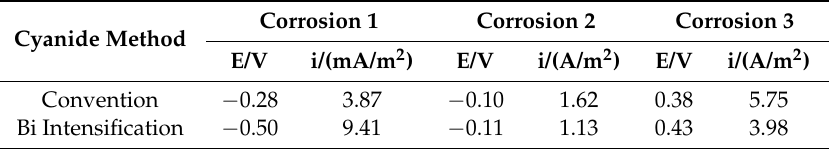
Table 1. Tafel results of gold electrode in cyanide